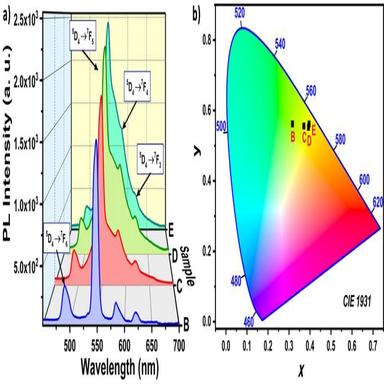
a) Photoluminescence spectra of PMMA pure and doped with Tb(tmhd)3 and RhB. b) The chromaticity coordinates CIE 1931 of the samples. The concentration of samples B to E are presented in.